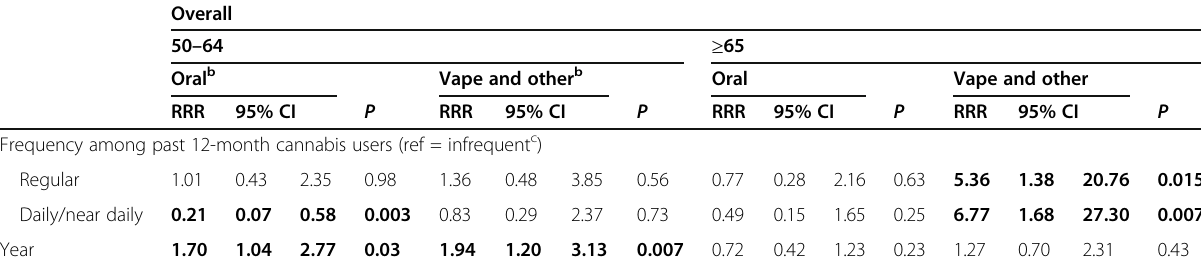
Table 3 Results from multinomial regression models a of past 12-month cannabis use frequency regressed on route of cannabis administration, 2014 – 2016 Washington state general population ( N =